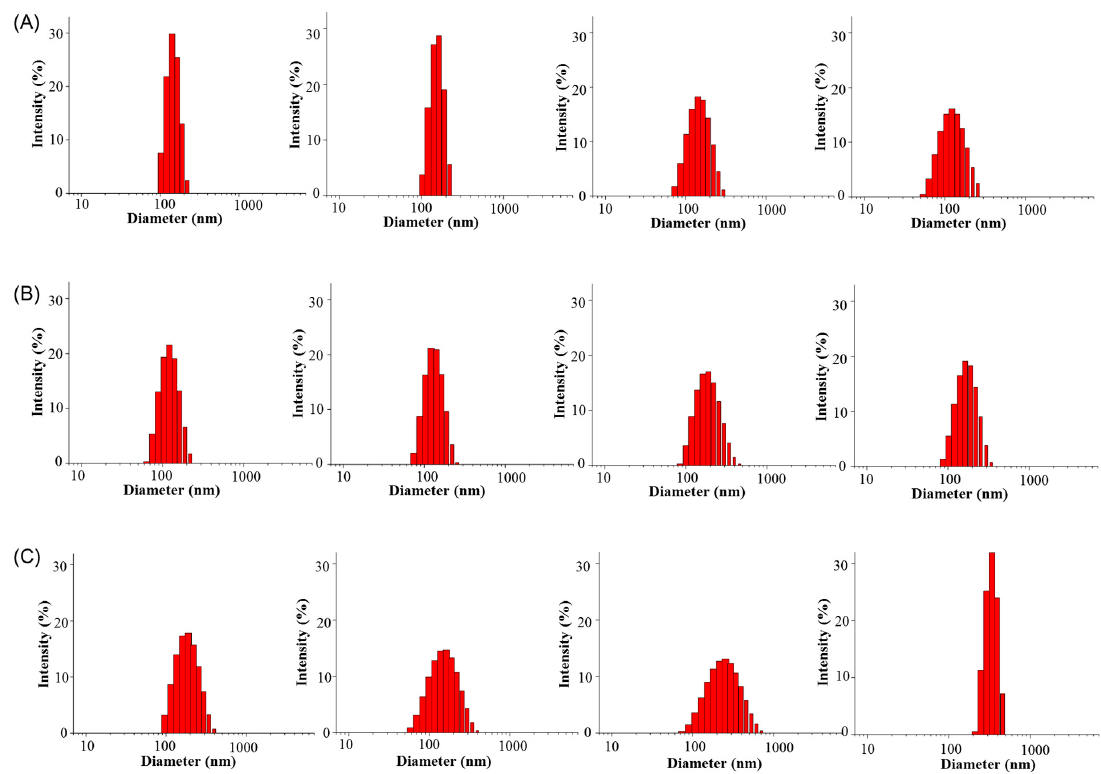
Figure 4. Particle size distribution of Pluronic F127 polymer micelles in 48 h (from left to right are 0 h, 6 h, 12 h, and 48 h, respectively).